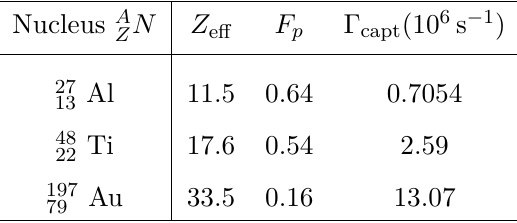
Table 2 . Atomic mass number A , (effective) atomic number Z ( Z eff ), form factor F p and capture rate Γ capt for the three nuclei Al, Ti, Au. Values from refs. [92, 93].